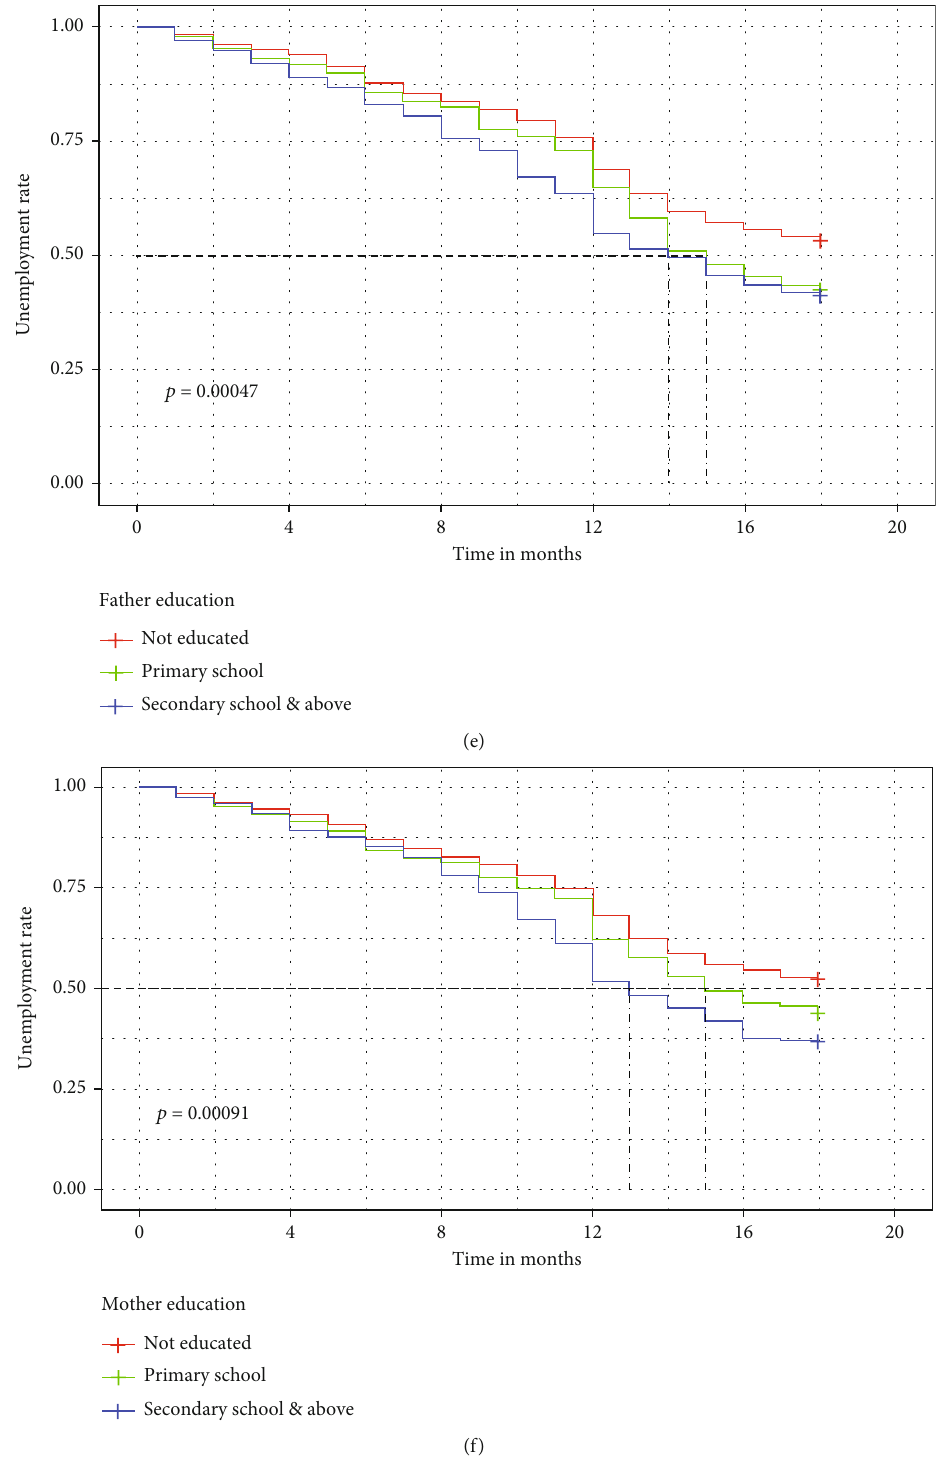
Figure 2: Job search time of graduates with